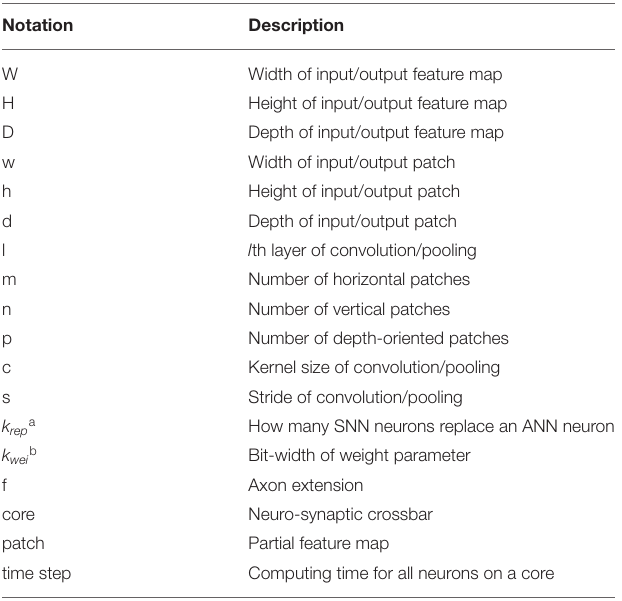
TABLE 1 | Summary of main notations.